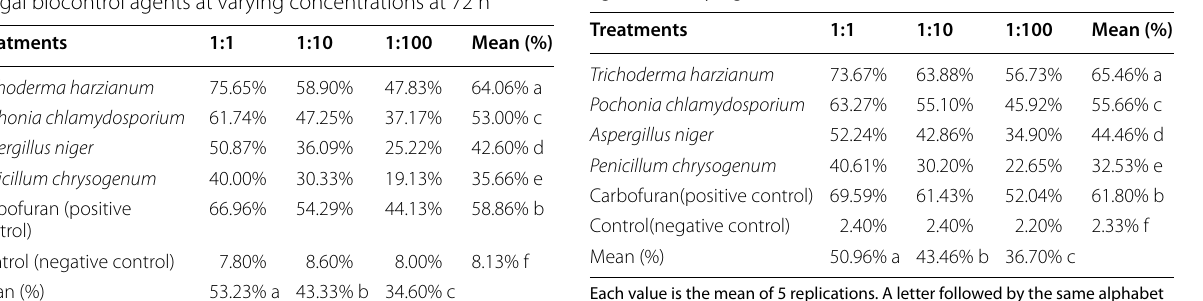
Table 5 Percentages of J2 mortality by various fungal biocontrol agents at varying concentrations at 48